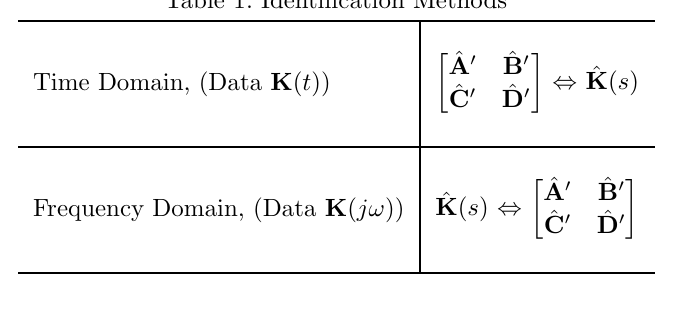
Table 1: Identification Methods